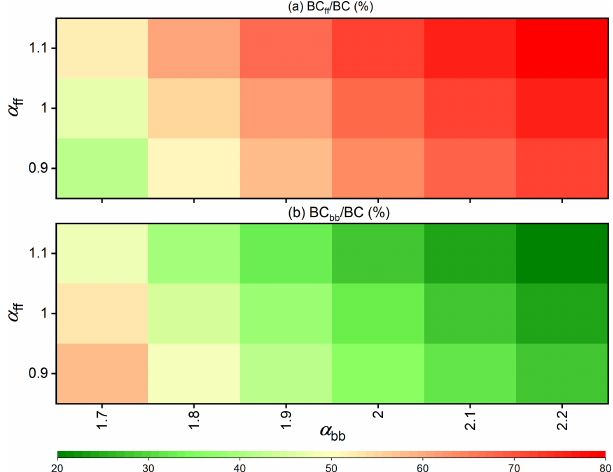
Figure 3. Variations in the (a) BC ff / BC and (b) BC bb / BC fractions with α ff and α bb